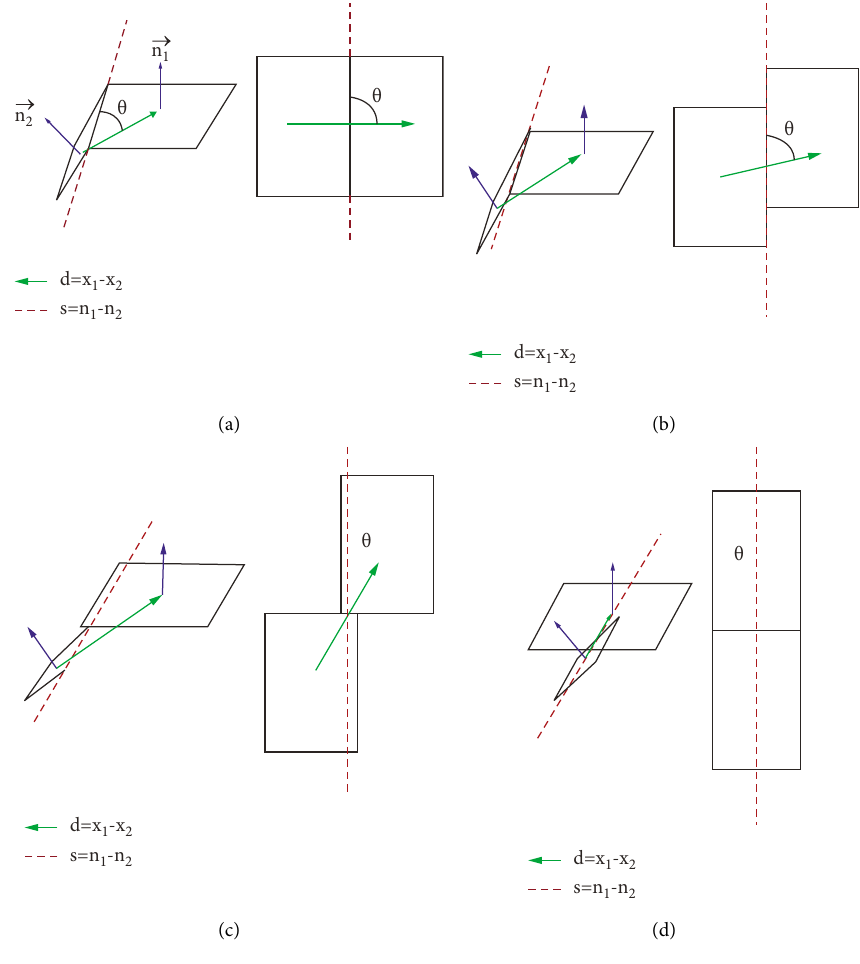
Figure 4: Sanity